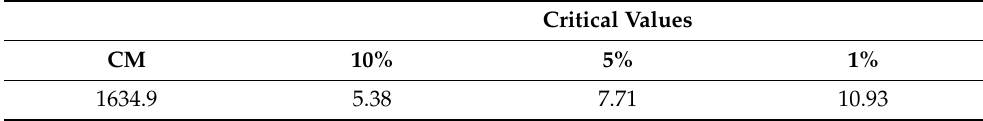
Table 2. Results for the conditional moment